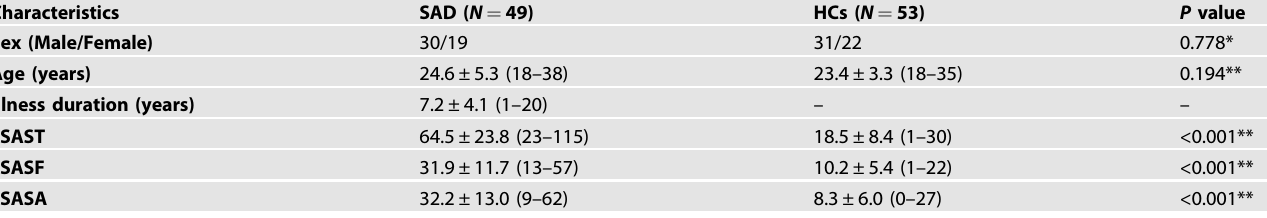
FD framewise displacement, HCs healthy controls, LSAST, LSASF, and LSASA total score and fear and avoidance factor scores on the Liebowitz Social Anxiety Scale (LSAS), SAD social anxiety